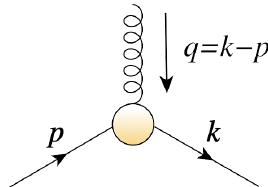
Figure 1 . Diagrammatic representation of the dressed quark-gluon vertex Γ µ ( k, p ) with its mo- mentum flow defined by the incoming quark momentum p , the outgoing momentum k and q = k − p